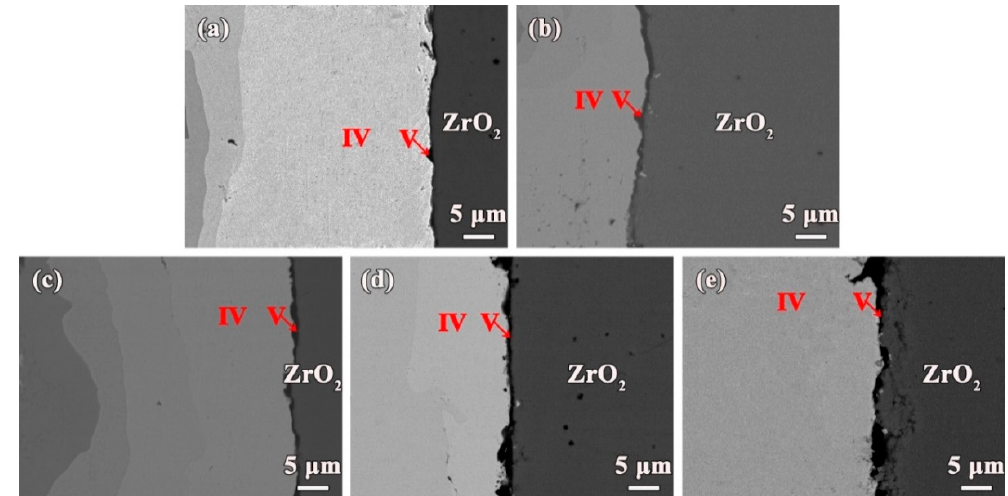
Figure 5. Microstructure of the TiO layer at different brazing temperature for 10 min: ( a ) 1110 °C, ( b ) 1130 °C, ( c ) 1150 °C, ( d ) 1170 °C and ( e ) 1190 °C.